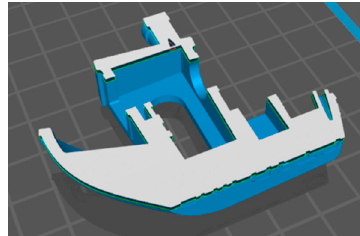
Figure 12. “Benchy” model sliced and prepared for the DLP method. Materials 2020 , 13 , x FOR PEER REVIEW